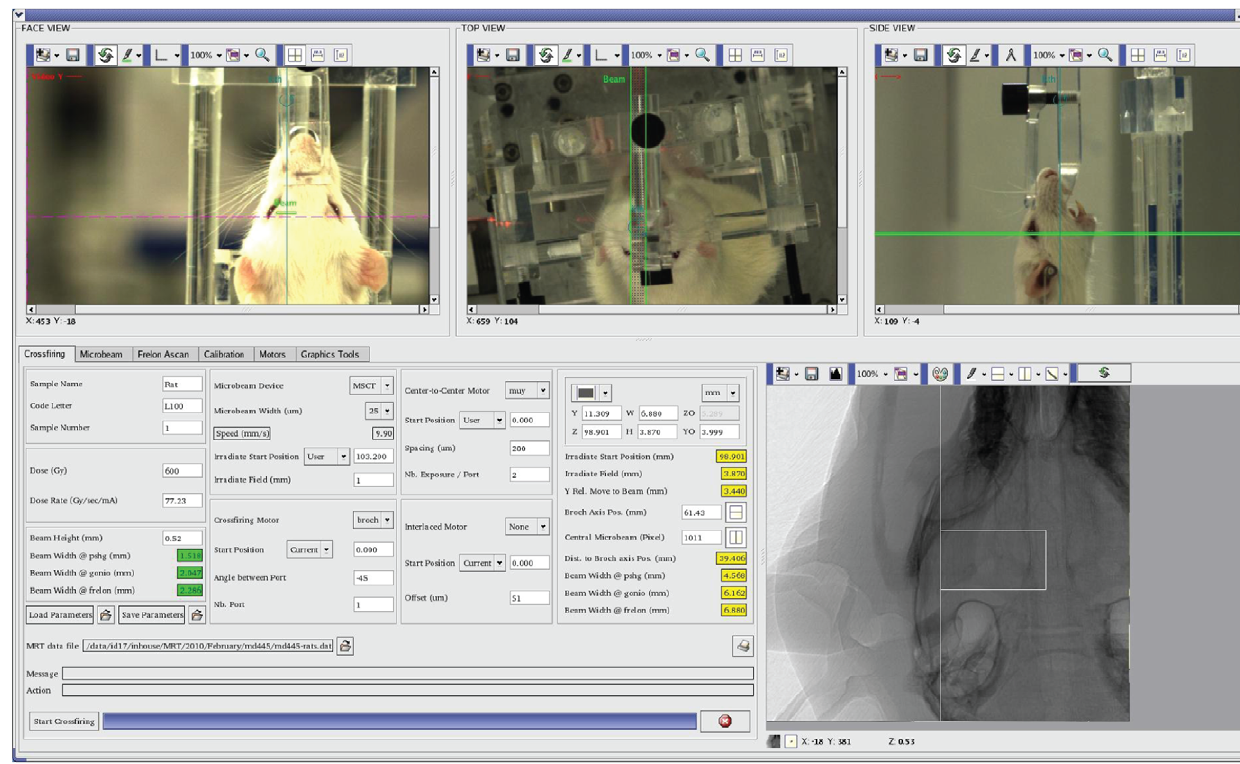
Figure 7. The control panel of the rat irradiation and imaging systems. After an optical prepositioning of the target performed through 3 remote controlled video cameras (three upper panels), high resolution target determination is performed by X-ray imaging. A computer-guided robotic arm (Kappa goniometer, below the rat and not visible in the Figure) moves the stereotactic headframe to acquire radioscopic image necessary to individuate the bregma (radiographic image, bottom right) from which stereotactic coordinates allow the